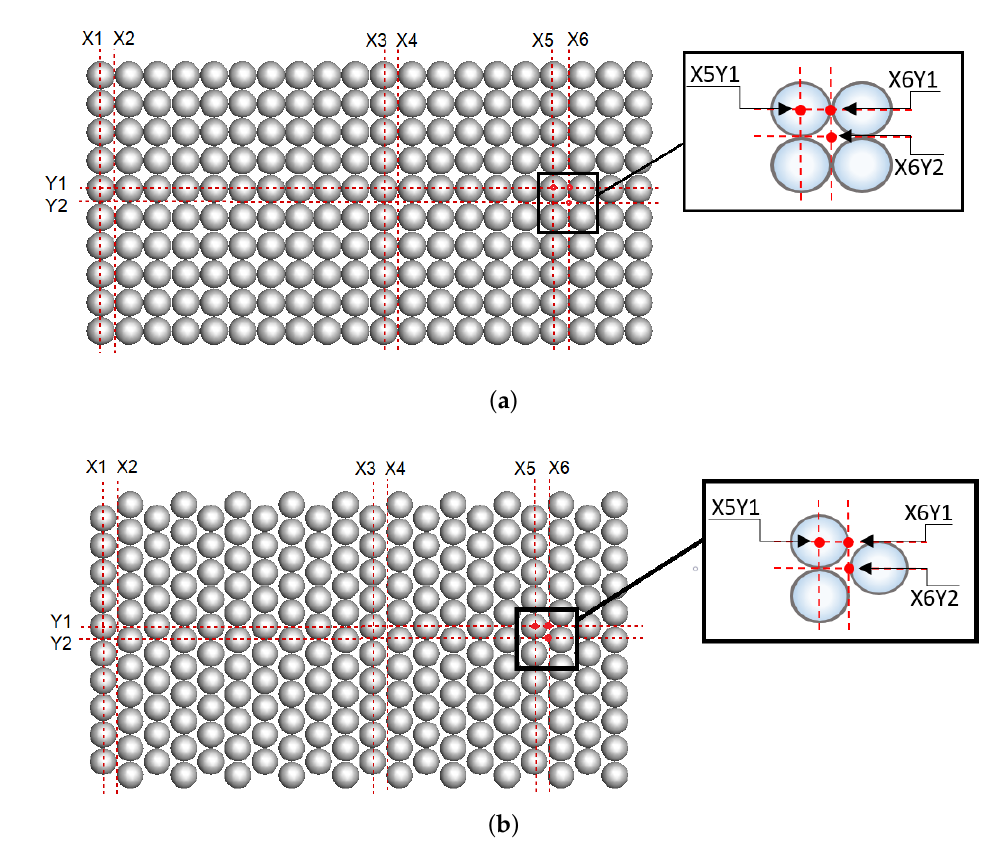
Figure 3. Ordered ( a ) and shifted ( b ) arrangement of sphere rows. Subfigures show the localizations of the control